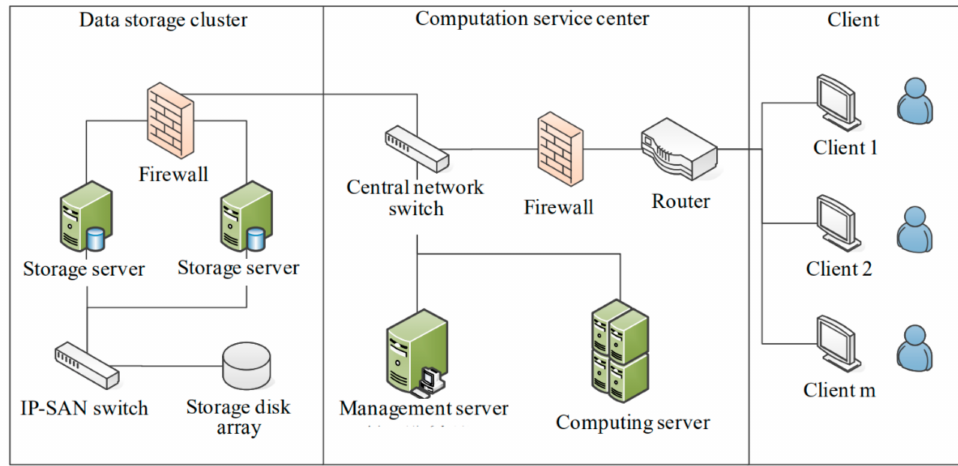
Figure 3. Physical deployment diagram of